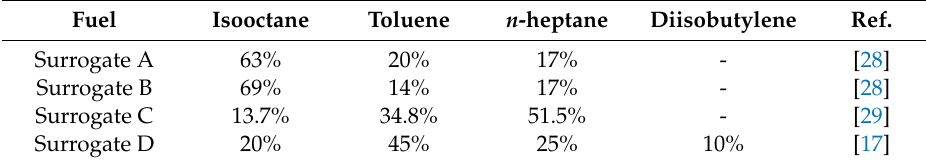
Table 2. Volume ratios of various components of several gasoline surrogate fuels.